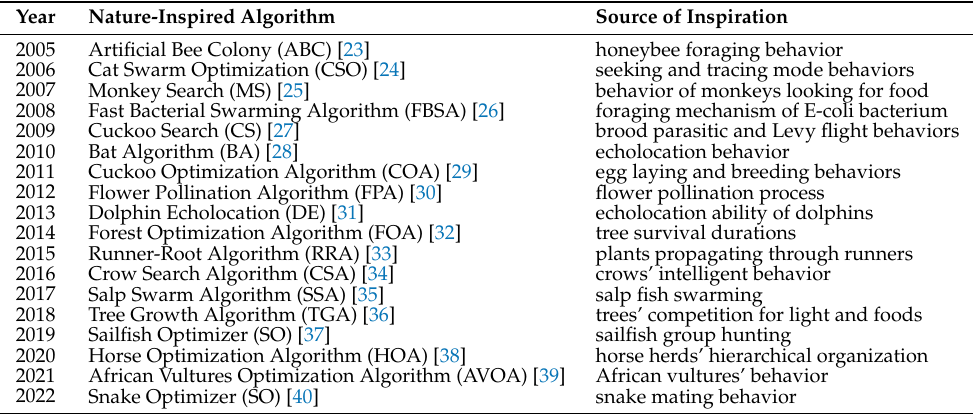
Table 1. Representative Nature-Inspired Algorithms for